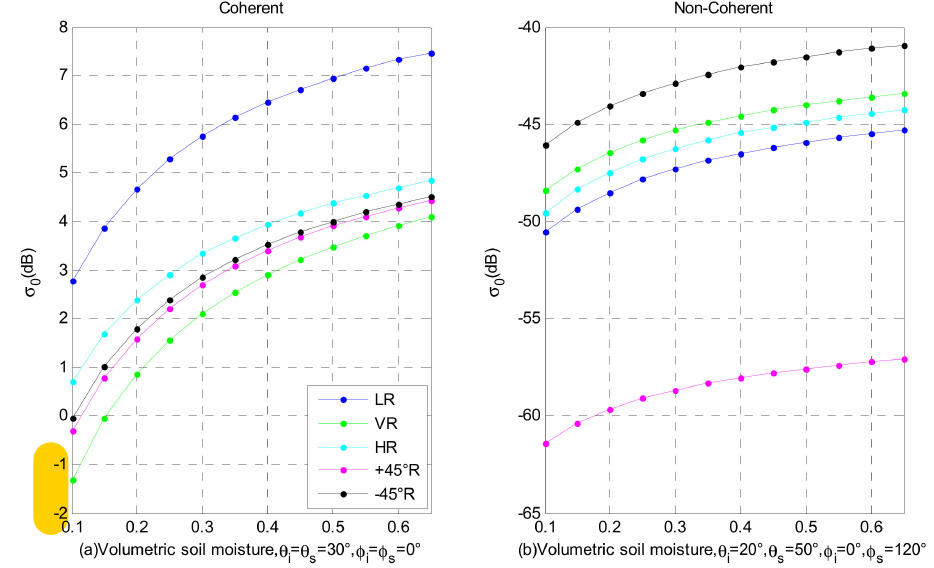
Figure 1. Scattering coefficients of various polarizations versus soil moisture: ( a ) coherent scattering; ( b ) non-coherent scattering.